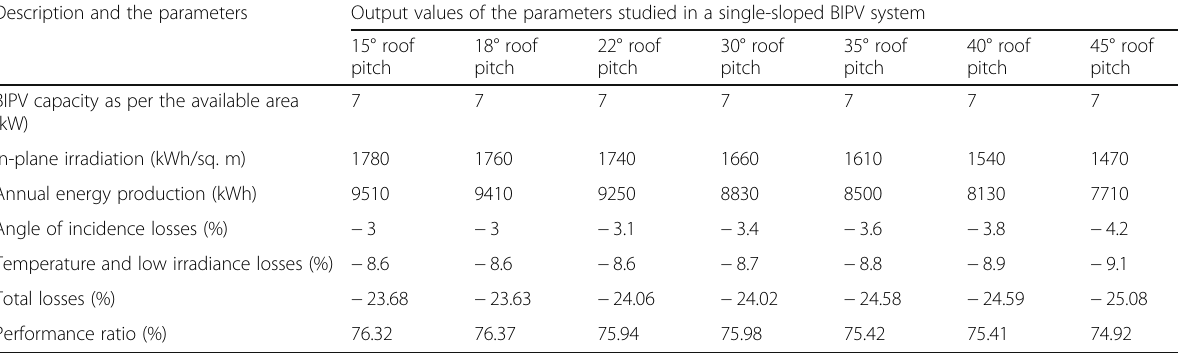
Table 3 Summary of the south-facing single-sloped BIPV system performance under seven pitched roof scenarios Description and the